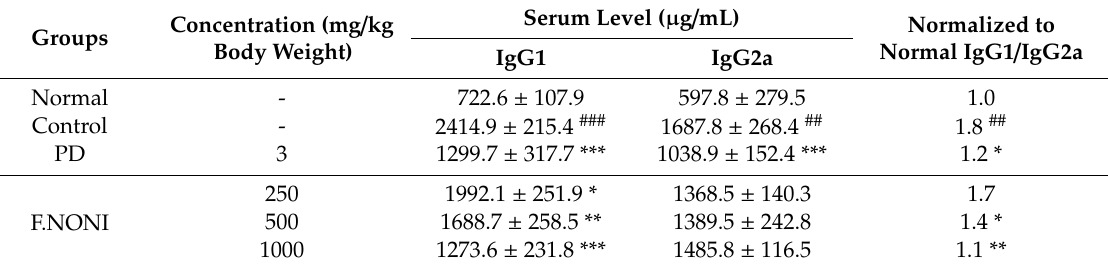
The levels of IgG1 and IgG2a were measured in serum of NC / Nga mice using ELISA. The ratio of IgG1 / IgG2a was presented in this table. The results were presented as mean ± SEM ( n = 5). ## p < 0.01, ### p < 0.001 vs. normal, * p < 0.05, ** p < 0.01, *** p < 0.001 vs. control. Normal, untreated group; Control, only atopic dermatitis induced by DNCB; PD, positive control (prednisolone 3 mg / kg) treated group; F.NONI (fermented Morinda citrifolia 250, 500, or 1000 mg / kg) treated